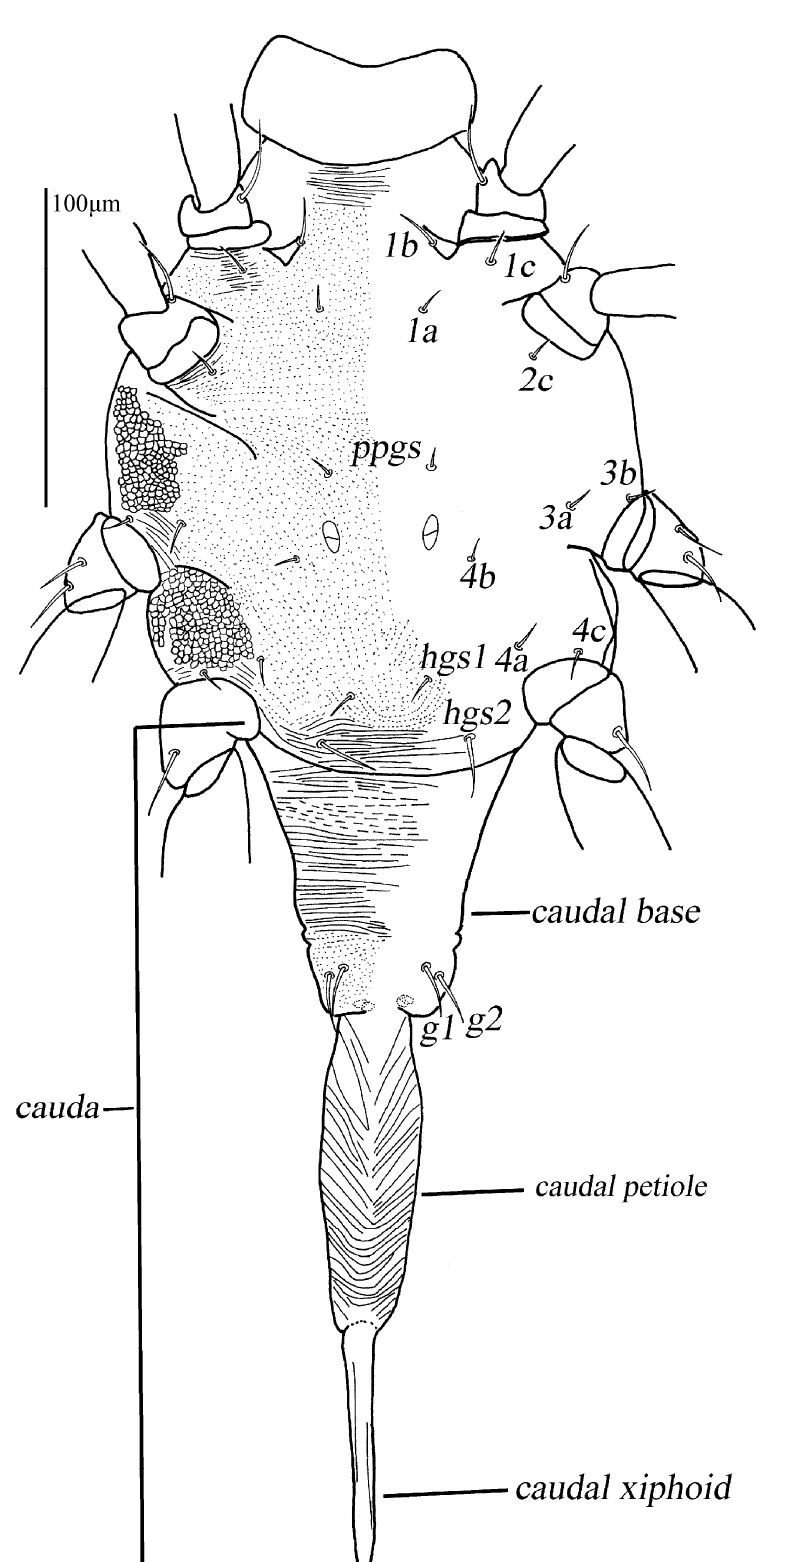
Figure 4. Cunaxicaudus mohanensis sp. nov. (male). Ventral idiosoma. Scale bar = 100 µm.